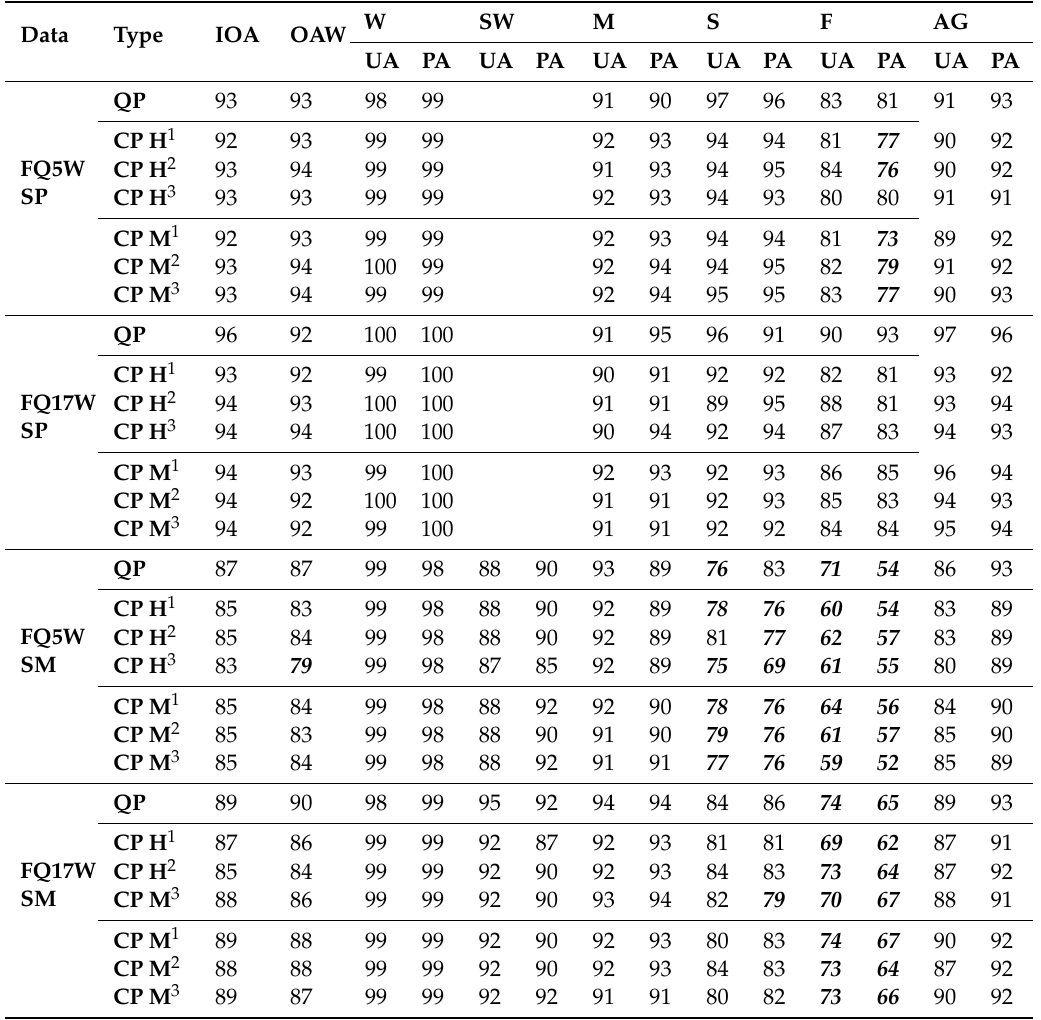
Table A2. Independent overall accuracies (IOA), independent overall accuracies for wetlands only (IOAW), and user’s (UA) and producer’s (PA) accuracies for models based on single QP, and the first (1), second (2), and third (3) simulations of high (H) and medium (M) resolution CP SAR data classified in combination with the high spatial resolution DEM and DSM data. Values ≤ 80% are bolded, and italicized to identify relatively high and low accuracies for a given class. Spring and summer images are abbreviated SP and